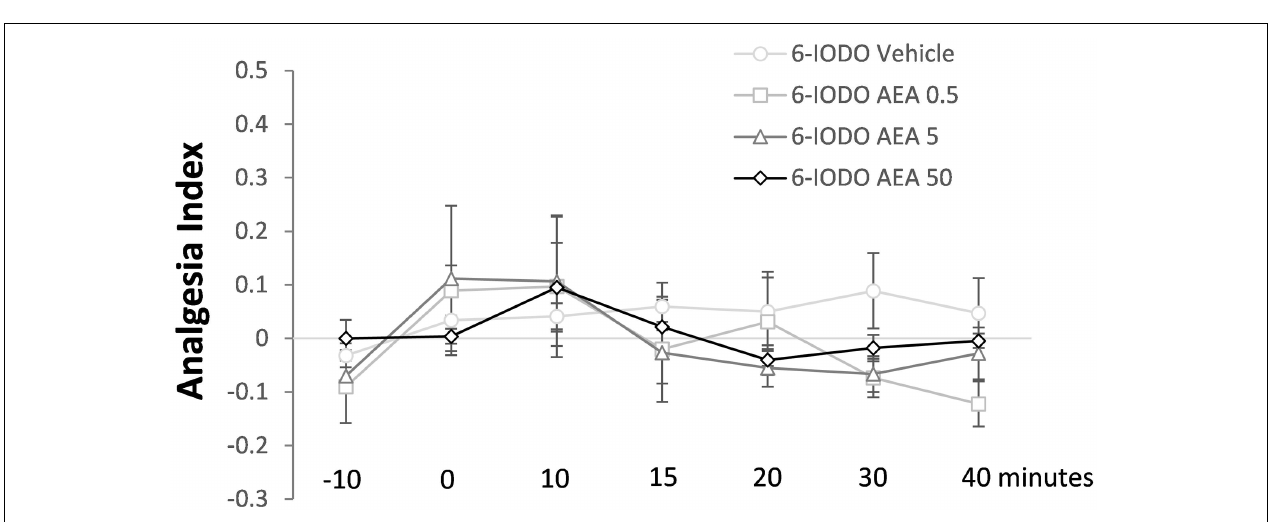
FIGURE 4 | Antinociceptive effects of intra-dPAG AM251 microinjection followed by local AEA on the TFL of mice exposed to the tail-flick test. Microinjections were performed at “zero” time. N = 4–7. Dots in the line chart represent mean ± SEM. ∗ P < 0.05 compared to vehicle-treated animals. Two-way ANOVA followed by Duncan post hoc